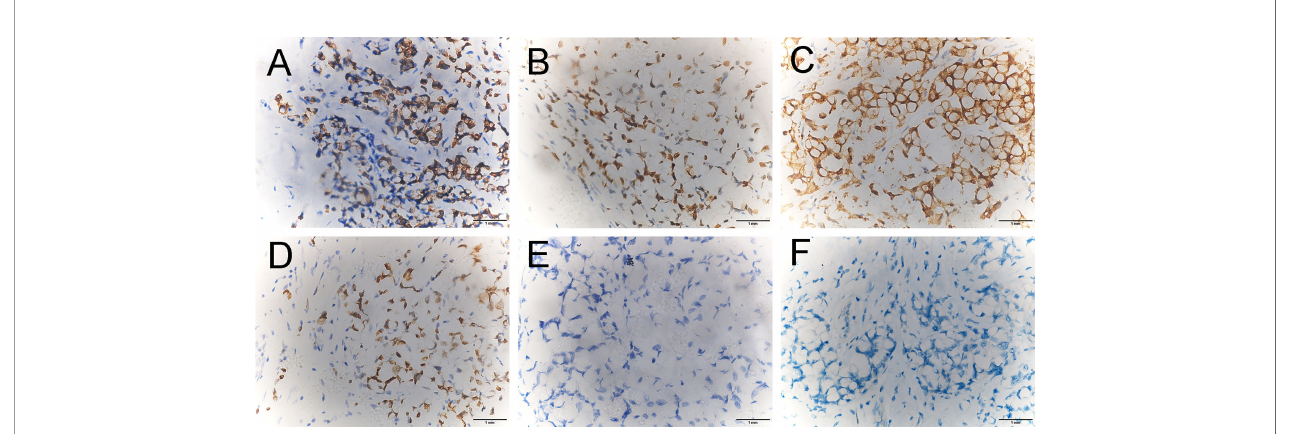
FIGURE 4 | Immunohistochemical staining revealed that the breast tumor cells were positive for CK20 ( A ×400), CDX-2 ( B ×400), Villin ( C ×400), and SATB-2 ( D ×400) and were negative for estrogen receptor (ER) ( E ×400) and progesterone receptor (PR) ( F ×400).